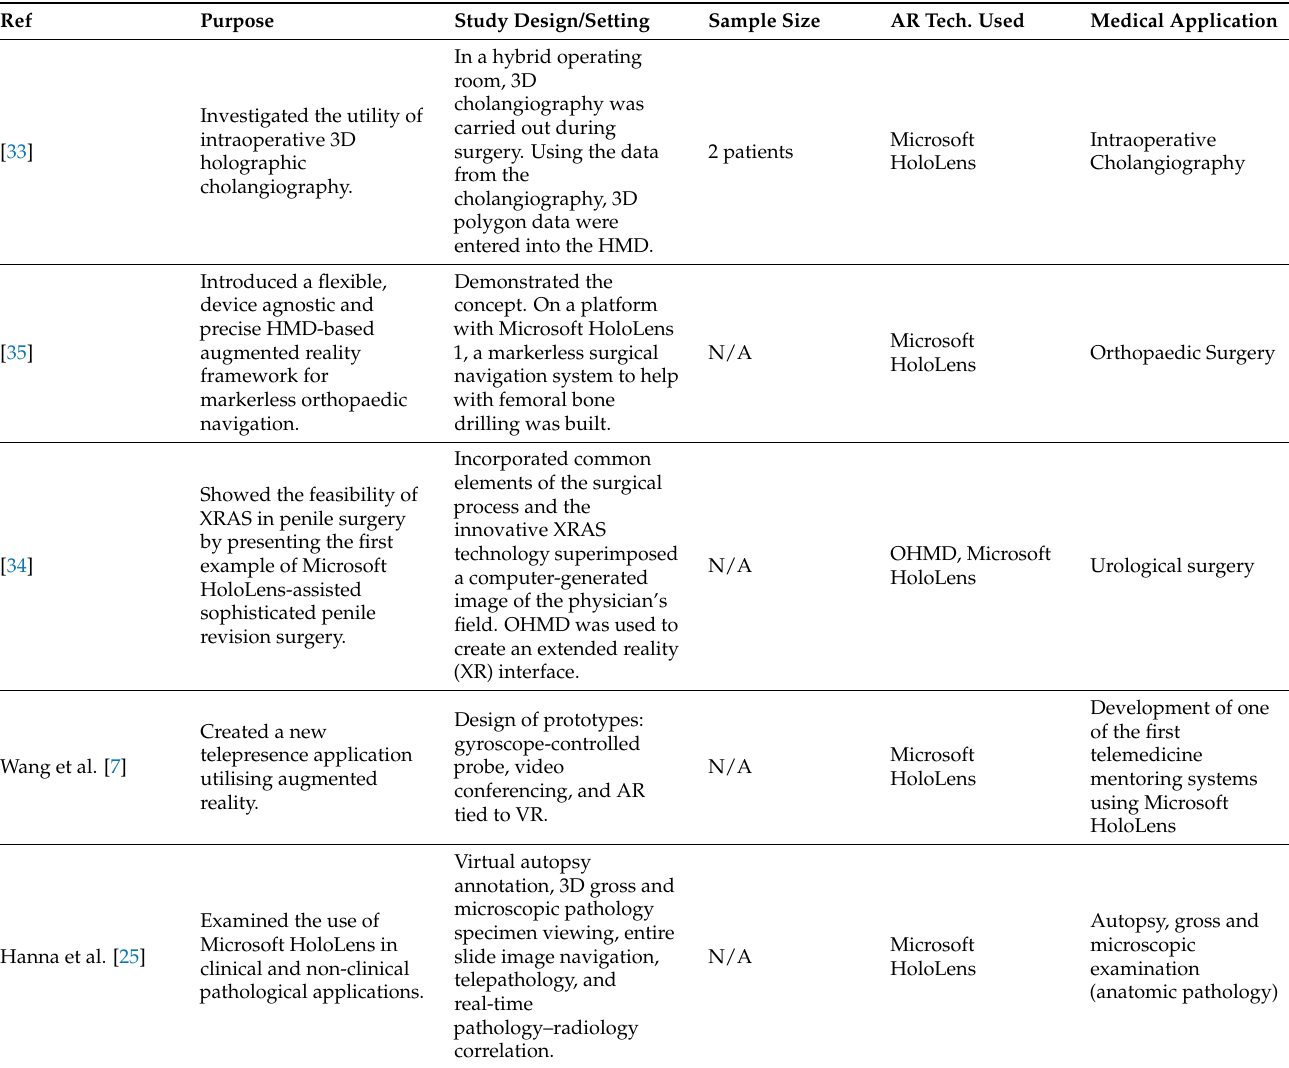
Table 2. The summary of the selected studies that focus on Microsoft HoloLens for surgical medical